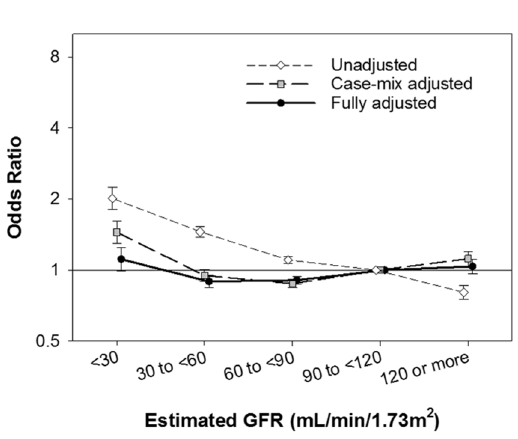
Table 3. Association of estimated GFR with post-operative non-pulmonary infectious complications.